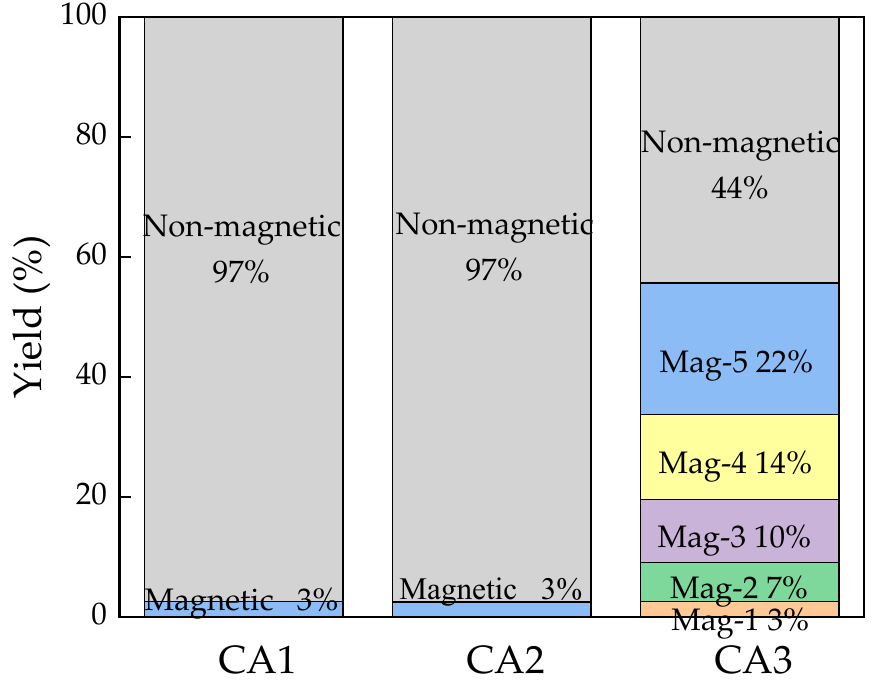
Figure 3. Magnetic fractions of three coal ash samples.